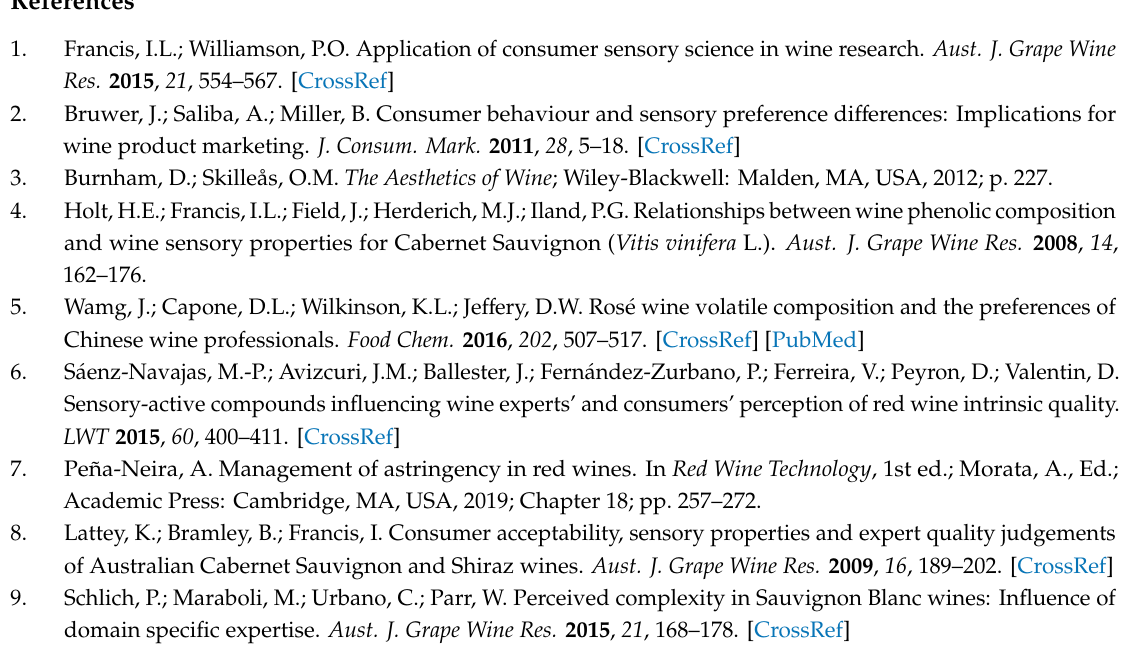
Figure S1: Final emotional tasting sheet and CATA list of attributes produced after the completion and analysis of the focus group discussions and that was further used in the consumer panel; Table S1: Coe ffi cients of correlation (Pearson) found between the variables of the Optimized Descriptive Profile (ODP); Table S2: Coe ffi cients of correlation (Pearson) found between the variables (attributes) of the emotional tasting sheet; Table S3: Coe ffi cients of correlation (Pearson) determination found between the variables (ODP x